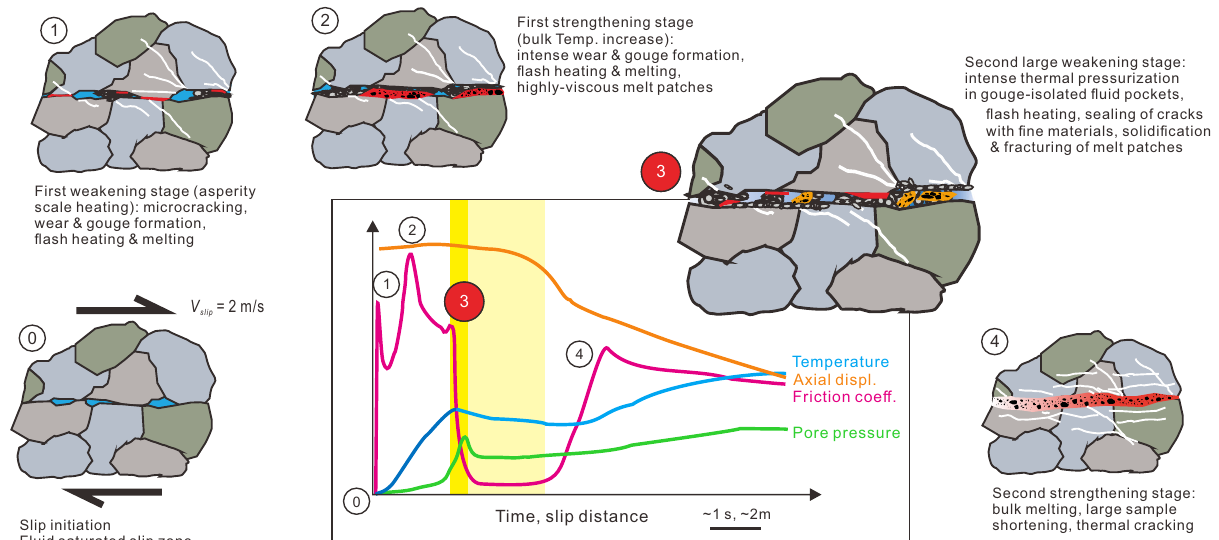
Fig. 5 | Deformation mechanisms operating during the experiments. This conceptual model (inspired by refs. 21 – 23 ) links the experimental measurements of the friction coef fi cient, axial displacement, and temperature (Fig. 2b – d) with the microstructural observations of the experimental products (Fig. 3a – e) and the results of the numerical modeling (Fig. 4a – d). In particular, the extreme fault